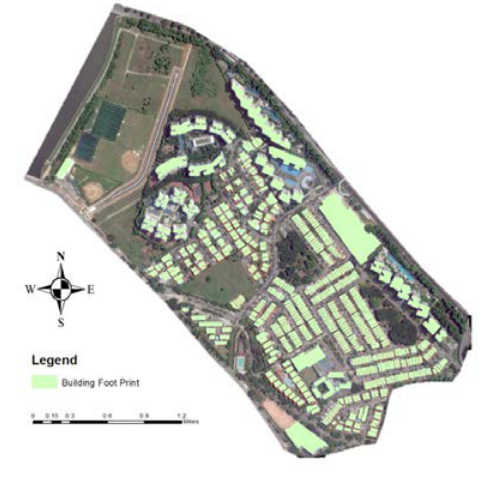
Figure 5: Extracted building footprint for buildings in the West Coast Area of